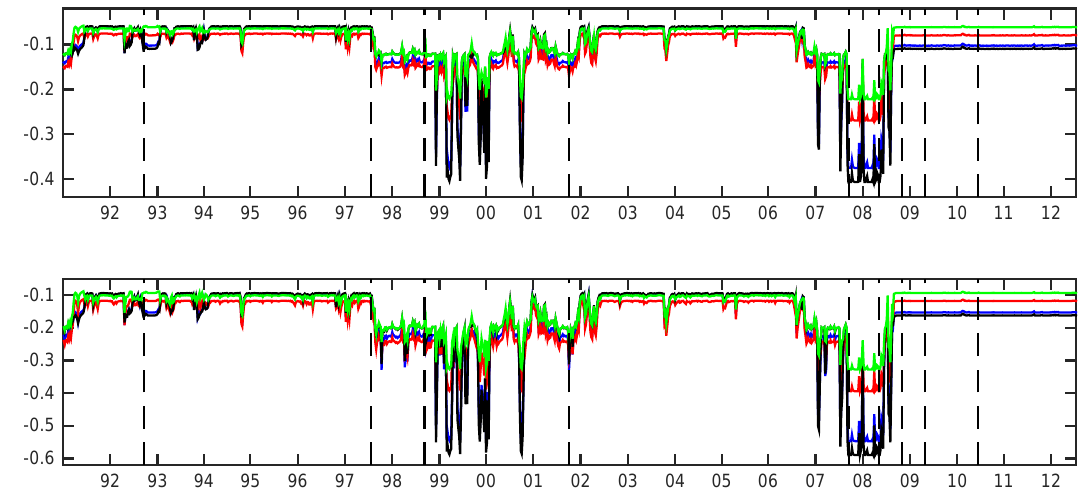
Figure 2. Total risk evaluated by multiple-conditional value-at-risk (CoVaR) (top) and multiple-conditional expected shortfall (CoES) (bottom) for the different sectors: banks (blue line), financial services (red line), life insurance (dark line) and non-life insurance (green line). Vertical dotted lines represent major financial downturns: see Figure 1 for a detailed description.